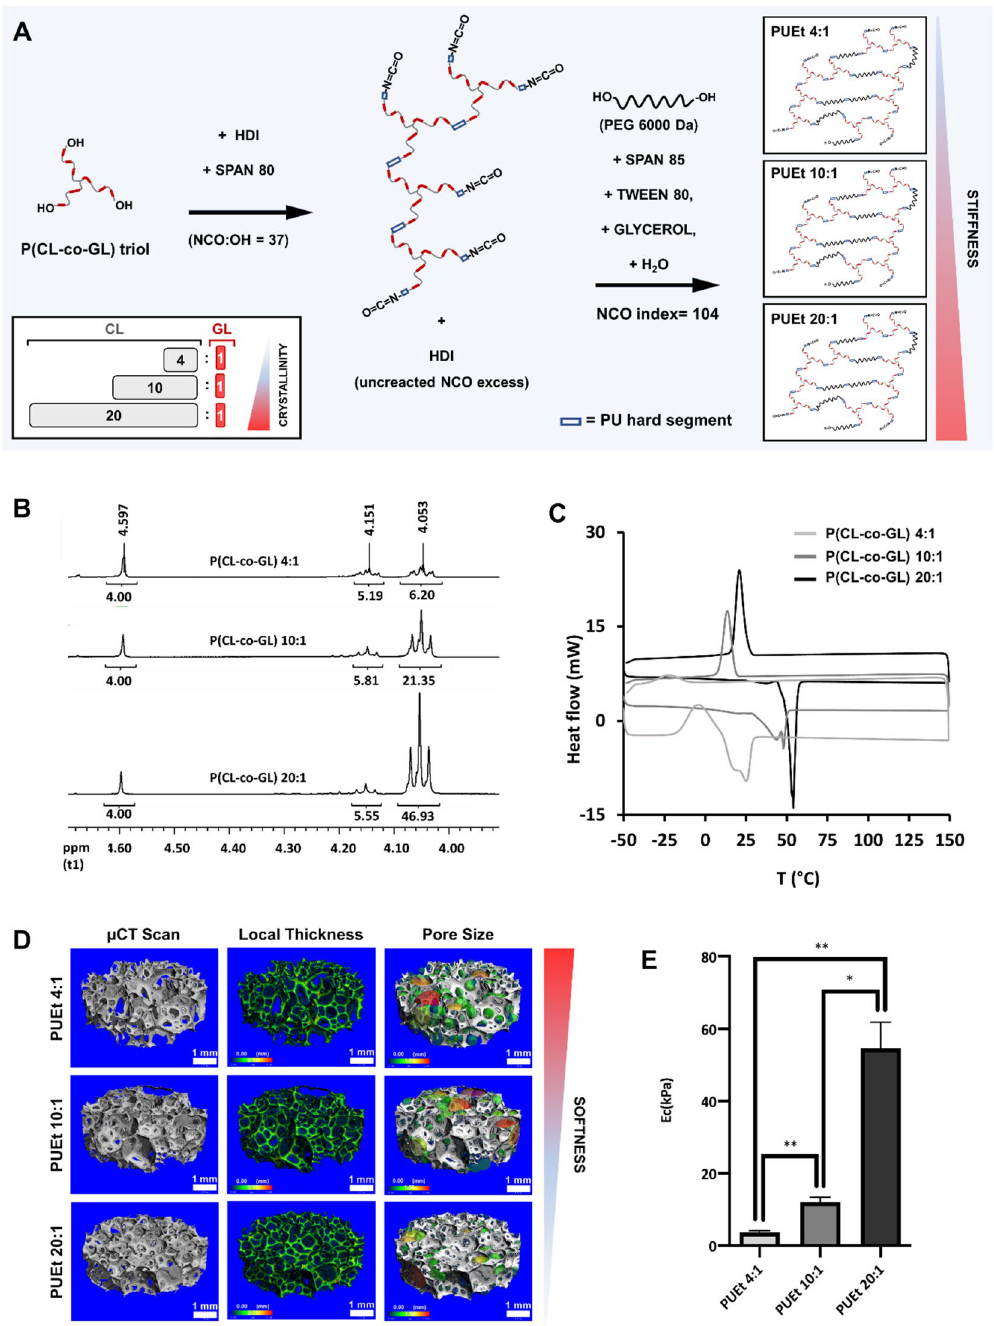
Figure 1. ( A ) Schematic representation of the synthetic route of 3 PUEt scaffolds of different stiffnesses, starting from 3 polyester triols: P(CL-co-GL) of different CL:GL ratios and accordingly of different crystallinities. Physicochemical properties of the 3 PUEt scaffolds formulations and the related precursors: ( B ) 1HNMR spectra of the 3 polyesters P(CL-co-GL) 4:1, P(CL-co-GL) 10:1, P(CL-co-GL) 20:1 showing correspondence between the ratio between CL and GL in the final products compared to the reactants; ( C ) DSC traces overlay of the 3 polyesters showing different thermal properties as a functions of the ratio CL: GL; ( D ) µCT scan micrograph (up), graphical rendering of the local thickness (middle) and of the pore size (bottom) of the 3 scaffolds formulations PUEt 4:1, PUEt 10:1 and PUEt 20:1; ( E ) graphical representation of the compression elastic moduli (Ec) of the 3 scaffolds formulations, showing statistically significant difference between: PUEt 10:1 and PUEt 20:1 (* p < 0.05), PUEt 4:1 and PUEt 10:1 (** = p < 0.025) and PUEt 4:1 and PUEt 20:1 (** p <